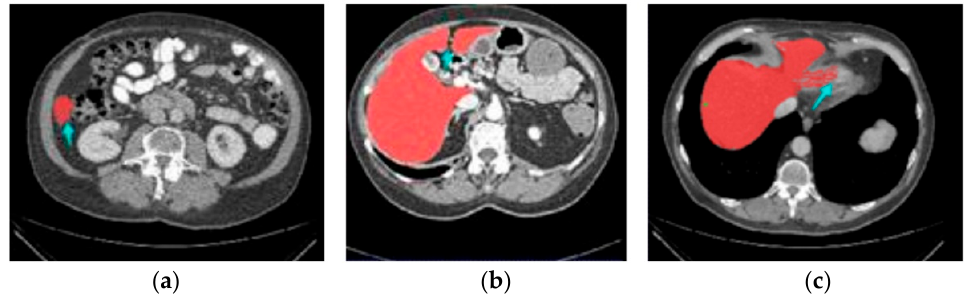
Figure 1. Three stimulating cases, including ( a ) Small liver zone, ( b ) Break liver part, ( c ) Blurred liver